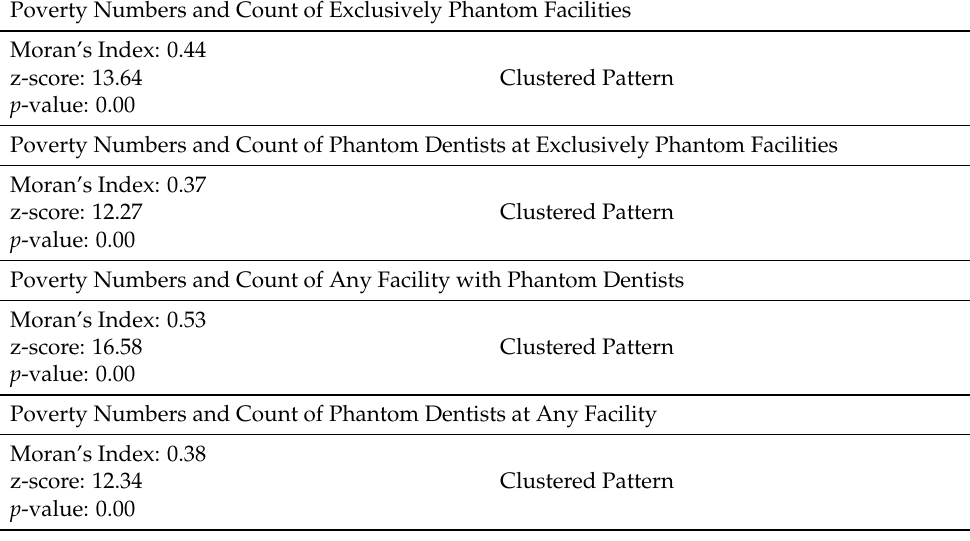
Table 7. Global Moran’s I Spatial Autocorrelation of poverty numbers and phantom networks within 700 feet of Manhattan census tract boundaries.